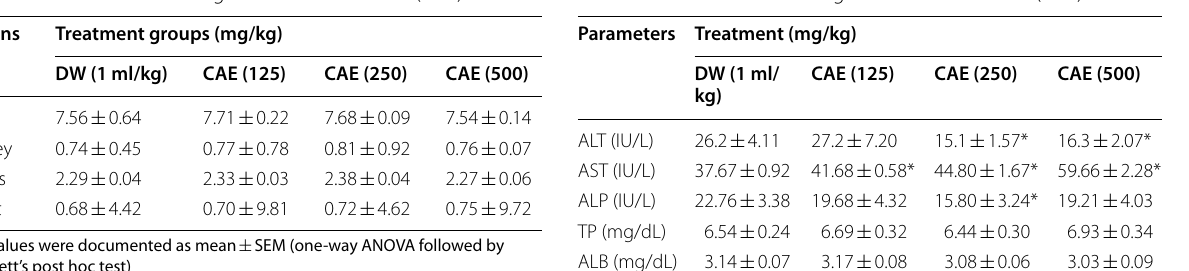
Table 3 Hepatic parameters of rats following 28-day repeated administration of Culcasia angolensis leaves extract